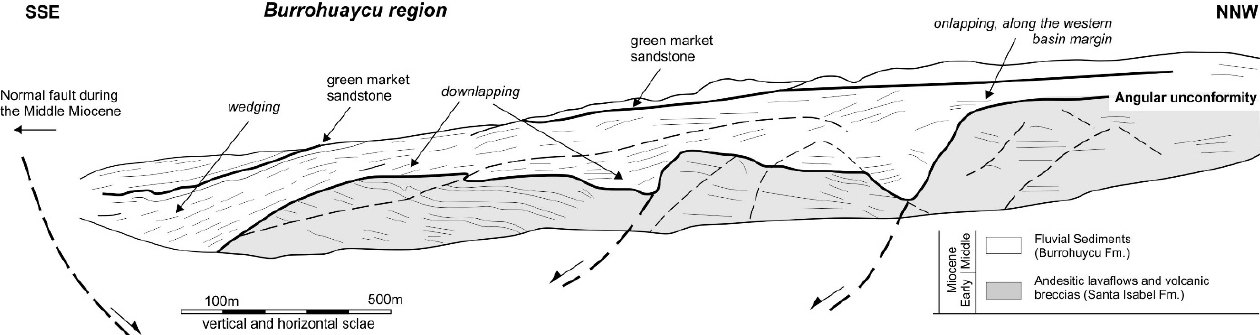
Figure 4. Cross ‐ section of the Girón–Santa Isabel basin along the Quebrada Burrohuaycu, showing Figure 4. Cross-section of the Gir ó n–Santa Isabel basin along the Quebrada Burrohuaycu, showing normal faulting. Modified by [41]. normal faulting. Modified by